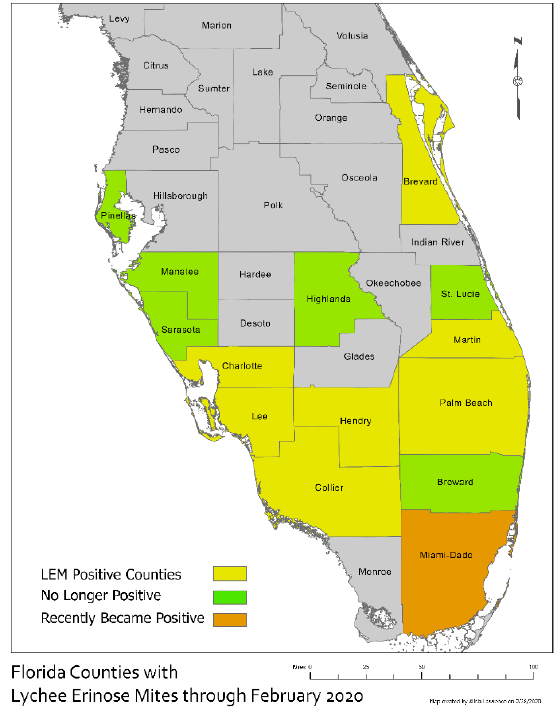
Figure 1. Current distribution of lychee erinose mite (LEM) ( Aceria litchii ) in Florida.